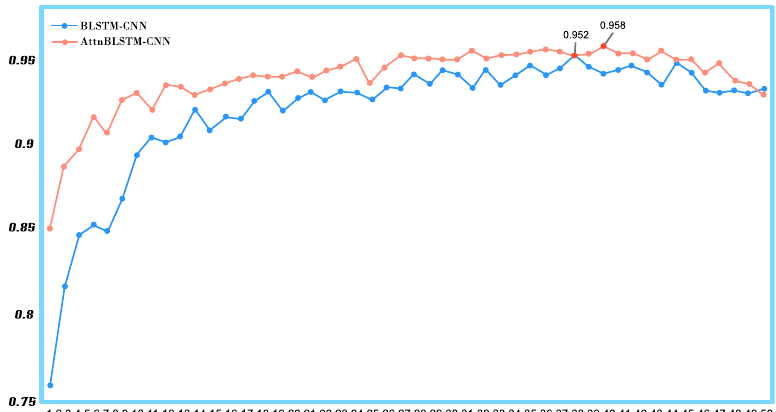
Figure 12. F1 value results of 50 iterations of AttnBiLSTM-CNN and BiLSTM-CNN.